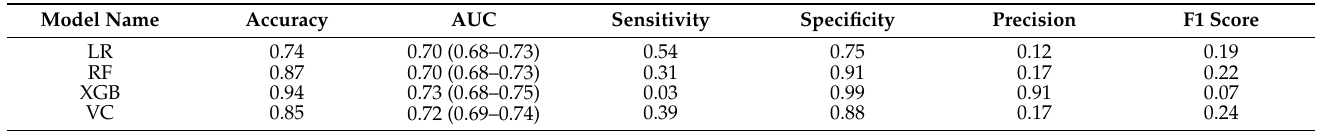
Table 3. Reduced-features model performance for predicting unscheduled return visits within 72 h by patients with abdominal pain.